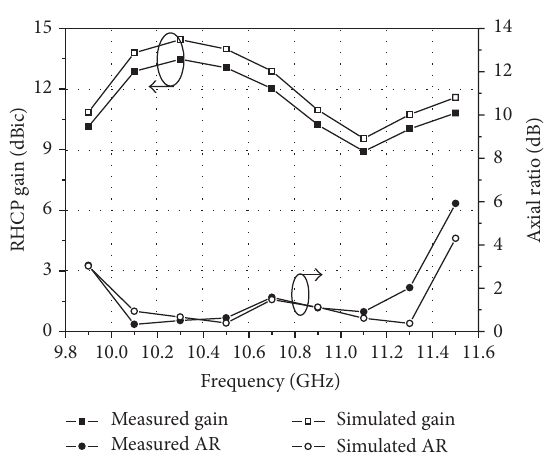
Figure 10: Measured and simulated gain, AR versus frequency.